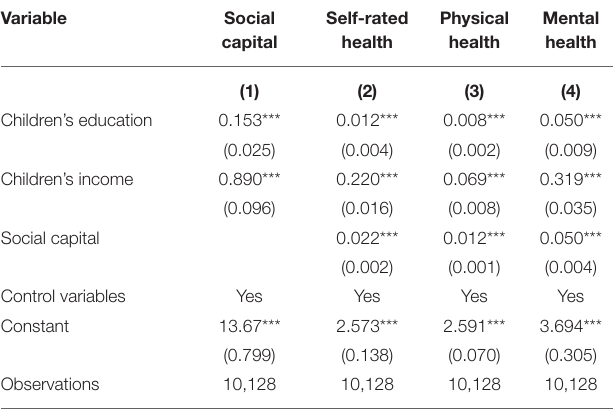
TABLE 6 | Analysis of multiple mediation effect of social